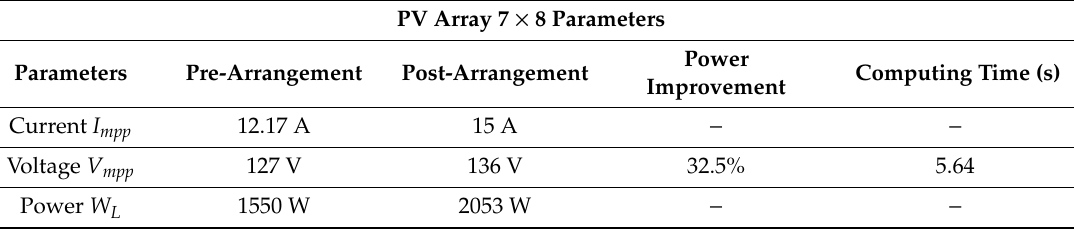
Table 8. PV array 7 × 8 parameters Pre and Post-arrangement.